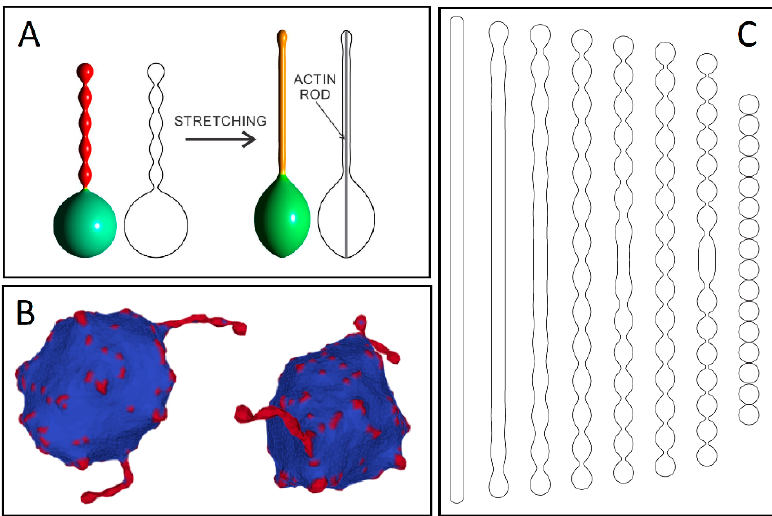
Figure 6. ( A ) Vesicle shapes calculated for two-component membrane, where one component has high positive intrinsic curvature. The red color represents the highest possible concentration of the membrane component with high intrinsic curvature (adapted from Reference [92]). ( B ) The results of the Monte Carlo simulation for non-axisymmetric vesicle shape without actin cytoskeleton (adapted from Reference [94]). ( C ) Analytically calculated axisymmetric vesicle shapes at small relative volume, calculated by minimization of the local membrane bending energy [95]. The calculated series of shapes is constrained by two limiting shapes, i.e. tubular vesicles on the left and necklace-like shapes on the right hand side of series of calculated shapes (adapted from Reference [50]).